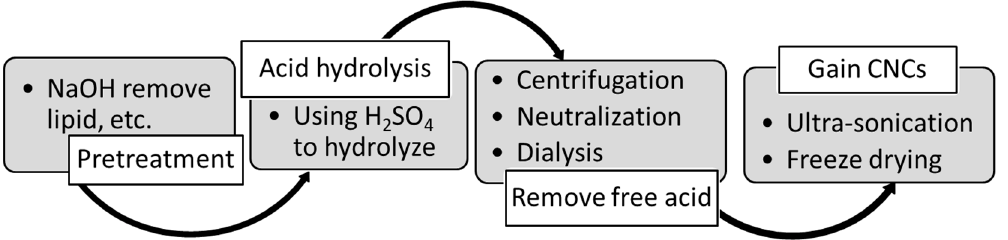
Figure 1. The procedure of CNC preparation.